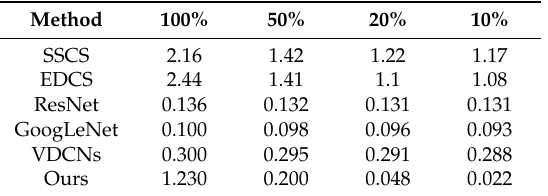
Table 7. Comparison of average runtime per image on Dataset 1 under different resolutions.